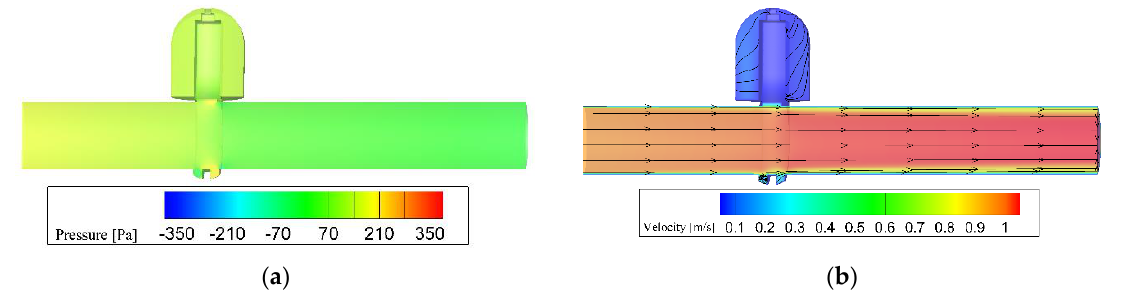
Figure 8. Pressure and velocity distributions on the symmetry plane: ( a ) Pressure distribution; and, ( b ) Velocity distribution.